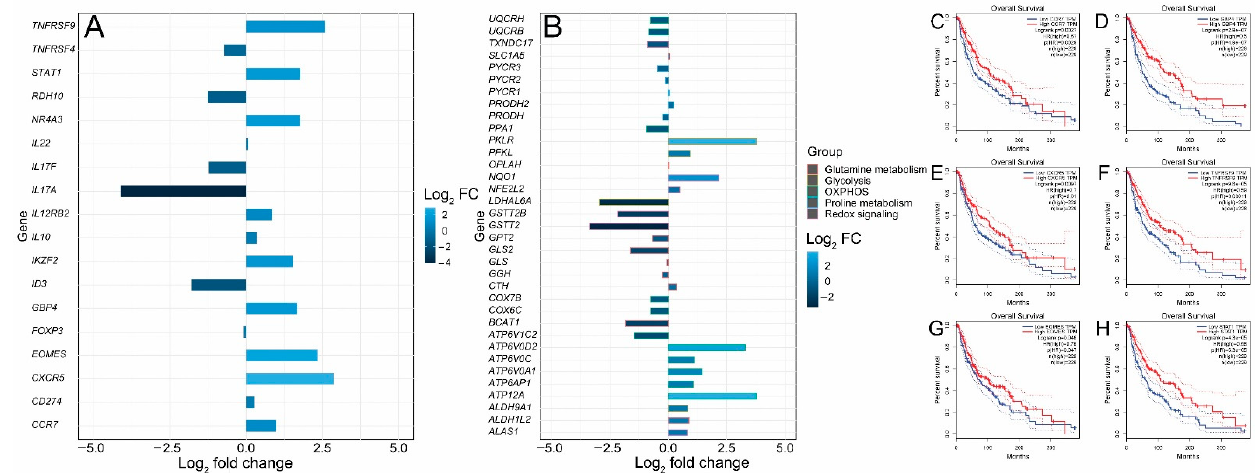
Figure 5. Differential expressions of Treg and metabolic genes and correlation analysis of gene expression and patients’ survival from TCGA. ( A ) Bar plot of upregulated and downregulated Treg signature genes. ( B ) Bar plot of upregulated and downregulated metabolic genes. ( C – H ) Survival curves of TCGA patients that express low and high levels of CCR7, CXCR5, EOMES, GBP4, TNFRSF9 and STAT1.